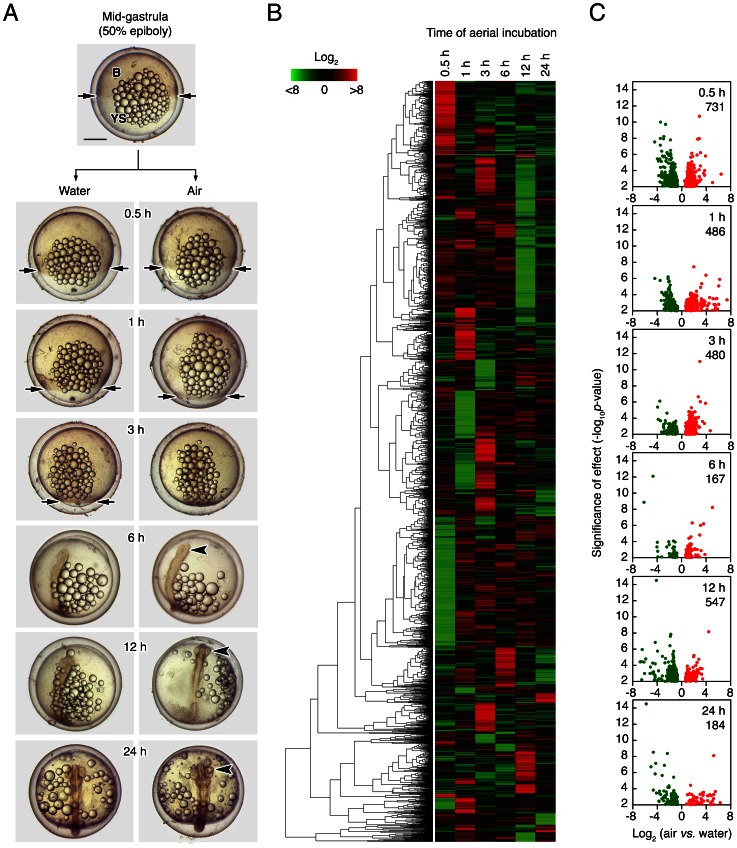
Stages and differential expression of Fundulus heteroclitus embryos incubated in water or exposed to air.(A) Representative photomicrographs of mid-gastrula embryos (50% epiboly), and of developing embryos after 0.5, 1, 3, 6, 12 and 24 h of aerial incubation at ∼100% RH as indicated. Note that aerial incubation enhances the rate of development, as indicated by the acceleration of epiboly (arrows) and the differentiation of eye and otic vesicles (arrowheads) in air exposed embryos with respect water submerged embryos from the same batch. (B) Hierarchical clustering of 2,381 putative genes that changed significantly (p<0.01) between air and water incubated embryos at each time point shown in A. Distances are measured using euclidean distance. Results are expressed as a matrix view of expression data where rows represent sequences and columns represent time points. The intensity of each colour denotes the standardized ratio between each value and the average expression of each sequence across all time points. Red pixels correspond to an increased abundance of mRNA, whereas green pixels indicate decreased mRNA levels. The list of all significantly regulated genes is given in Table S2. (C) Pairwise differences at each time point during aerial incubation. Significances of differences as −log10(p-values) are plotted against log2 differences in expression (air vs. water). Colors in these plots correspond to the colors of the gene tree in panel 1B.